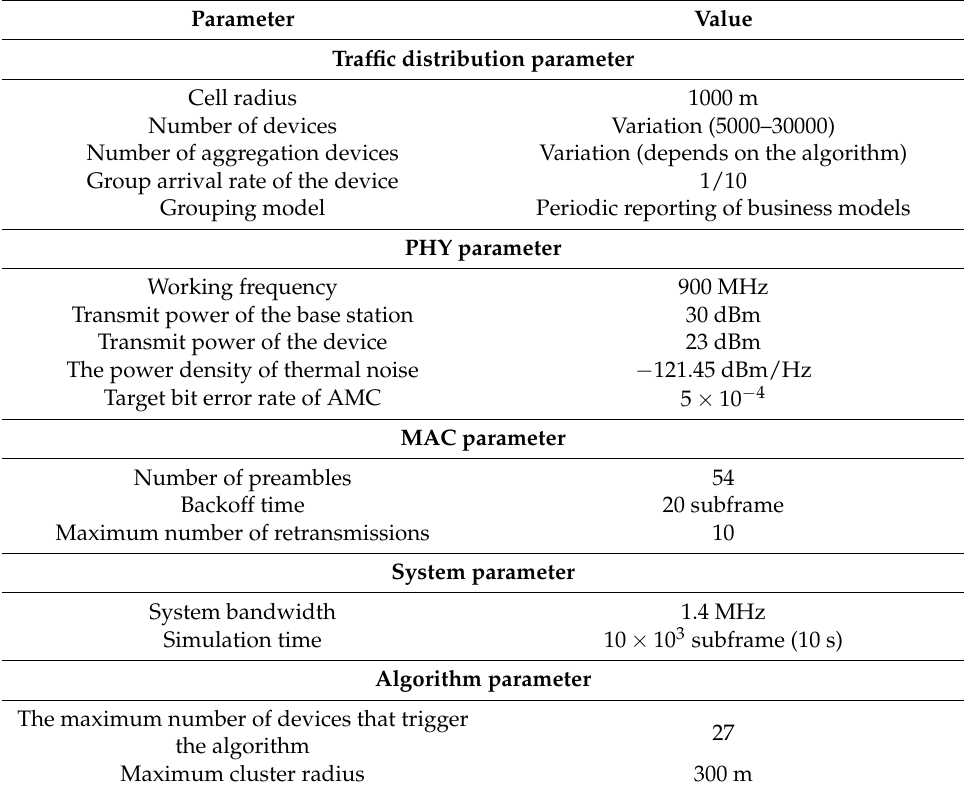
Table 3. List of main simulation